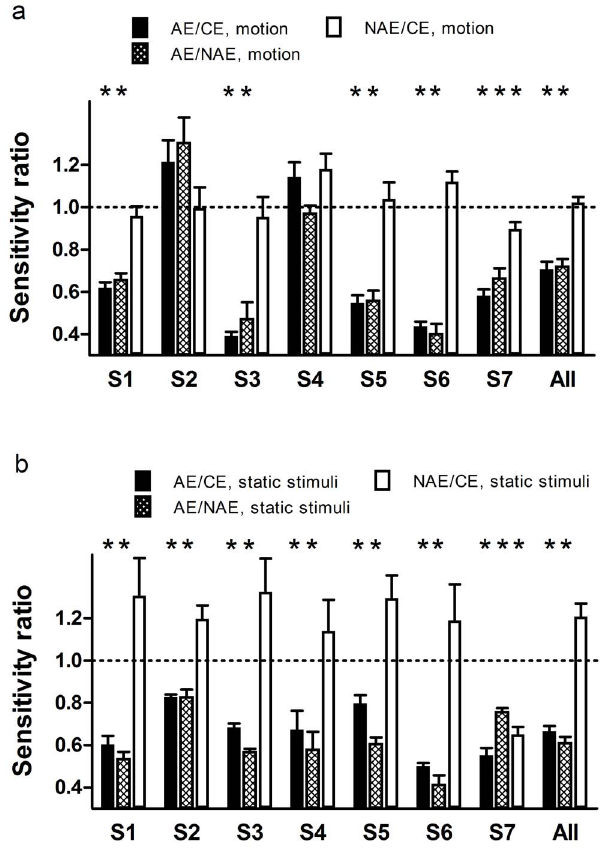
Figure 6. Averaged sensitivity ratios between the amblyopic eyes (AE), non-amblyopic eyes (NAE), and control eyes (CE) for second-order motion (a) and static second-order stimuli (b). Dash line, the value (1) used in t -test. *, statistically different from 1 ( p , 0.05) and a mean value lower than 1.